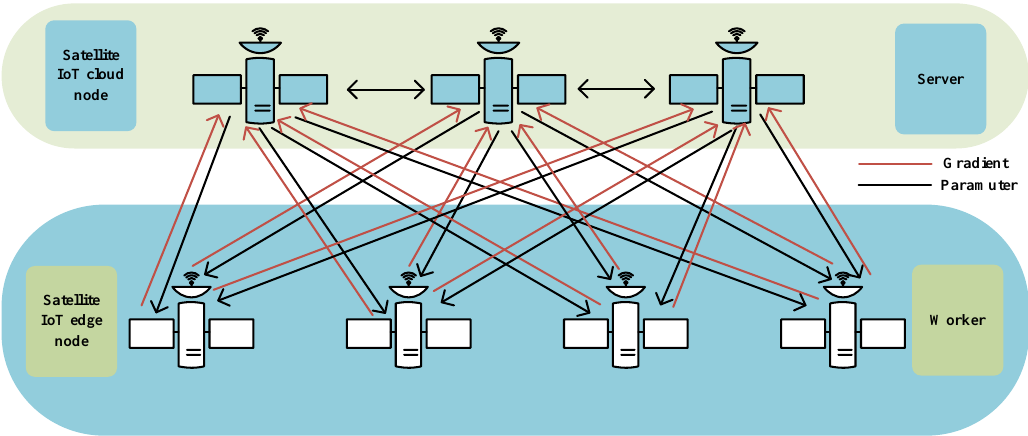
Figure 2. Cross-layer satellite IoT edge intelligent computing architecture’s neural network Figure 2. Cross- layer satellite IoT edge intelligent computing architecture’s neural network training training process.